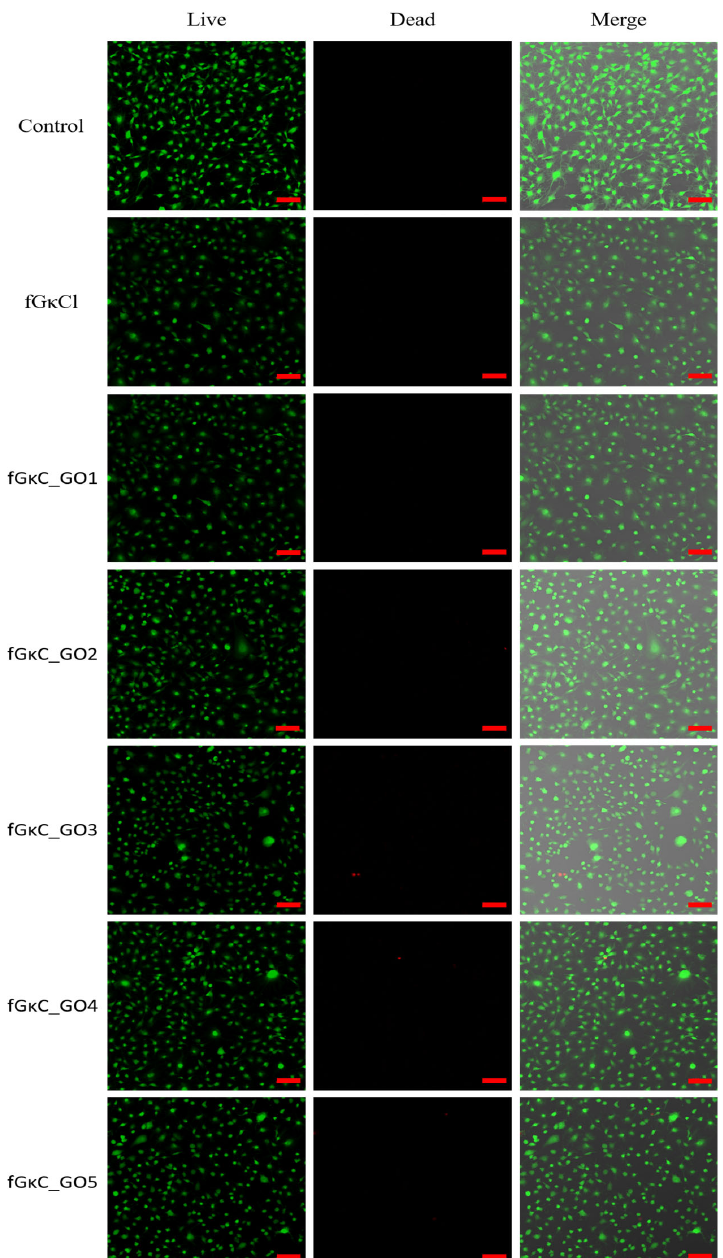
Figure 8. LIVE/DEAD cell viability assay. MC3T3-E1 cell viability after the exposure for 24 h to 12.5% extract of the fG κ C, fG κ C_GO1, fG κ C_GO2, fG κ C_GO3, fG κ C_GO4 and fG κ C_GO5 composite blends. The scale bar represents 100 μ m.